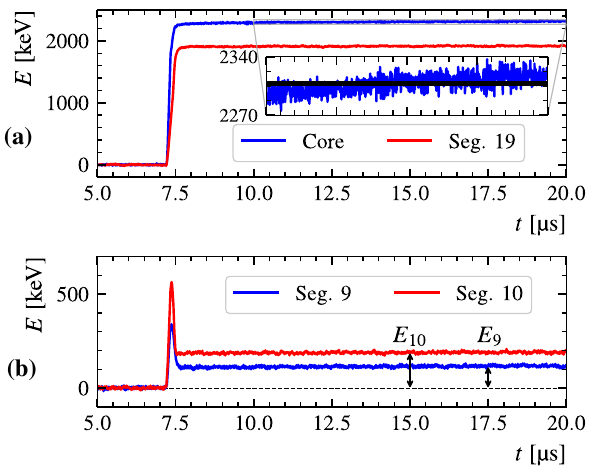
Fig. 10 Pulses of a typical event with net electron trapping of the a core and segment 19 and b the two closest segments 9 and 10 of the measurement from RSS at ϕ = 180 . 6 ◦ and r = 32 . 8mm. The observed energies, E 9 and E 10 , are also indicated. The horizontal line in the inset in a is at the mean of the tail of the core